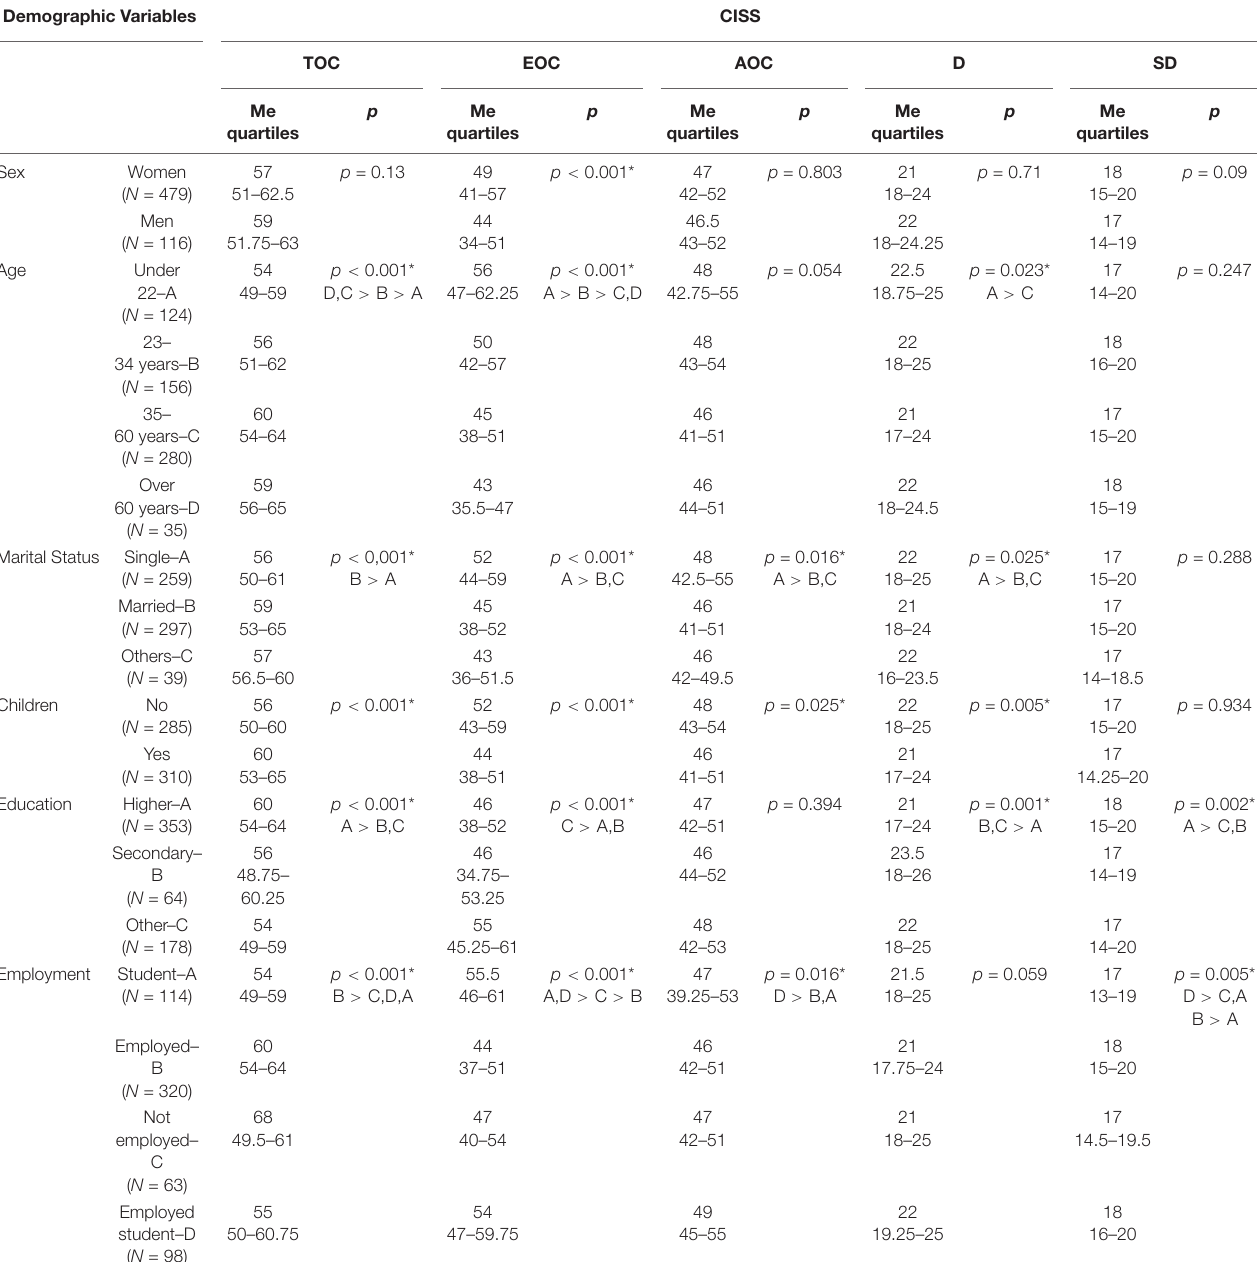
TABLE 3 | Task-oriented, emotion-oriented, and avoidance-oriented coping and demographic variables. Demographic Variables